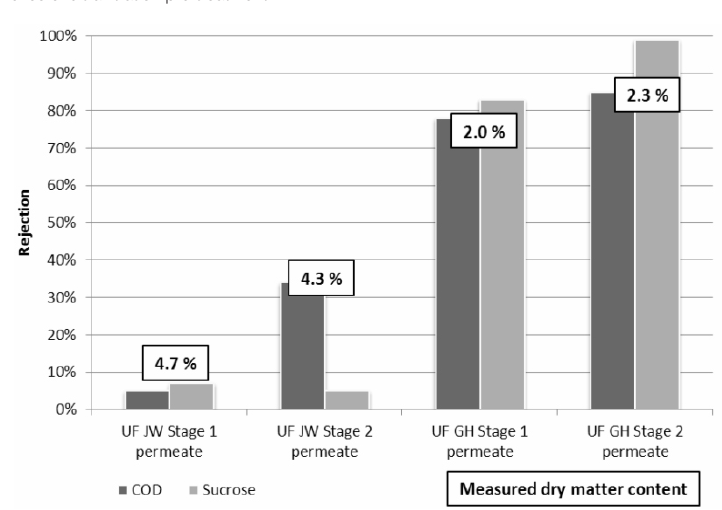
Figure 6. Chemical oxygen demand and sucrose rejection in cases of